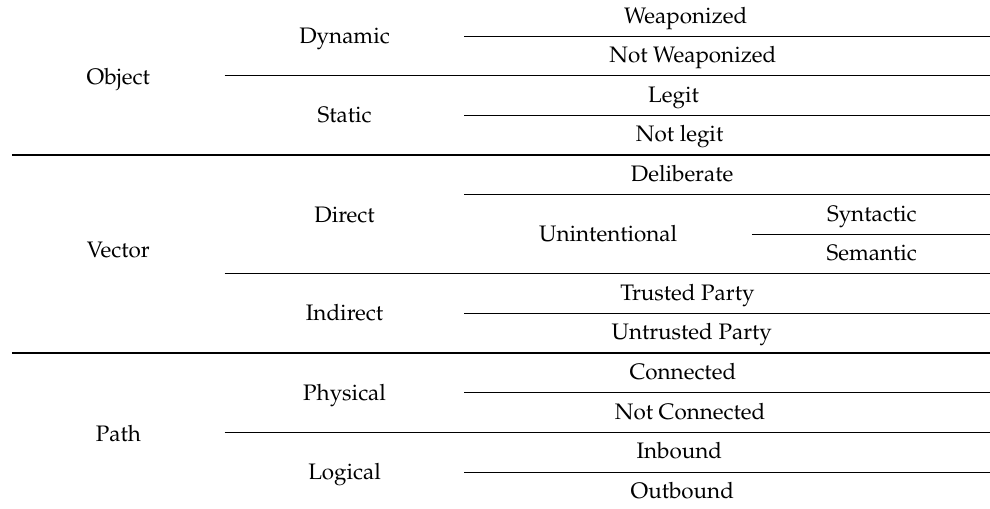
Table 2. Proposed taxonomy for delivery